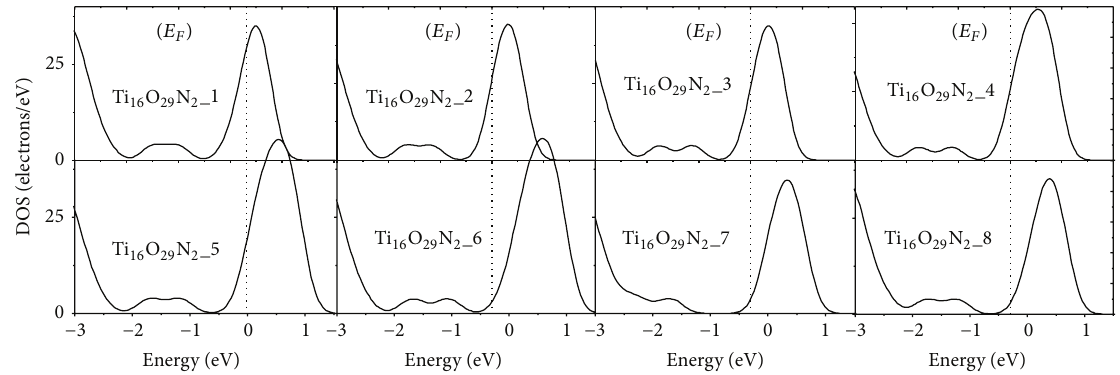
Figure 9: The total density of states of eight kinds of Ti 16 O 29 N 2